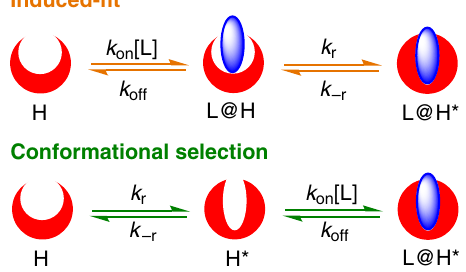
Fig. 1 Two binding mechanisms involving conformational changes. Induced- fi t: ligand binding occurs before conformational change; conformational selection: conformational changes occurs prior to ligand